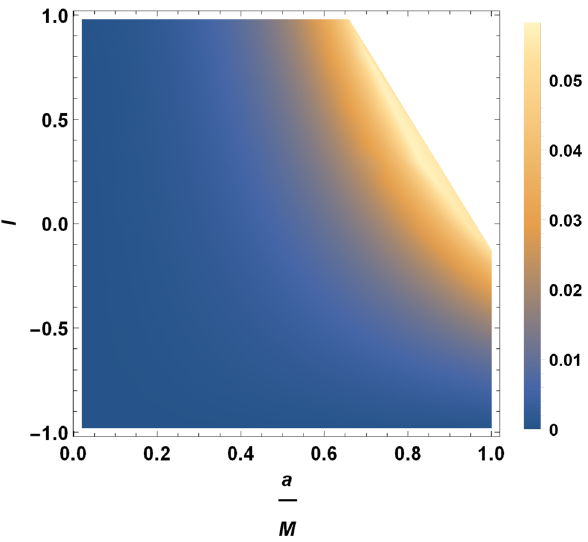
Fig. 21 Theobservablefordeviationfromcircularity (cid:2) C asafunction of black hole parameters. This is for b = 0 . 1 and k = 0 . 1 with the angle of inclination θ = 17